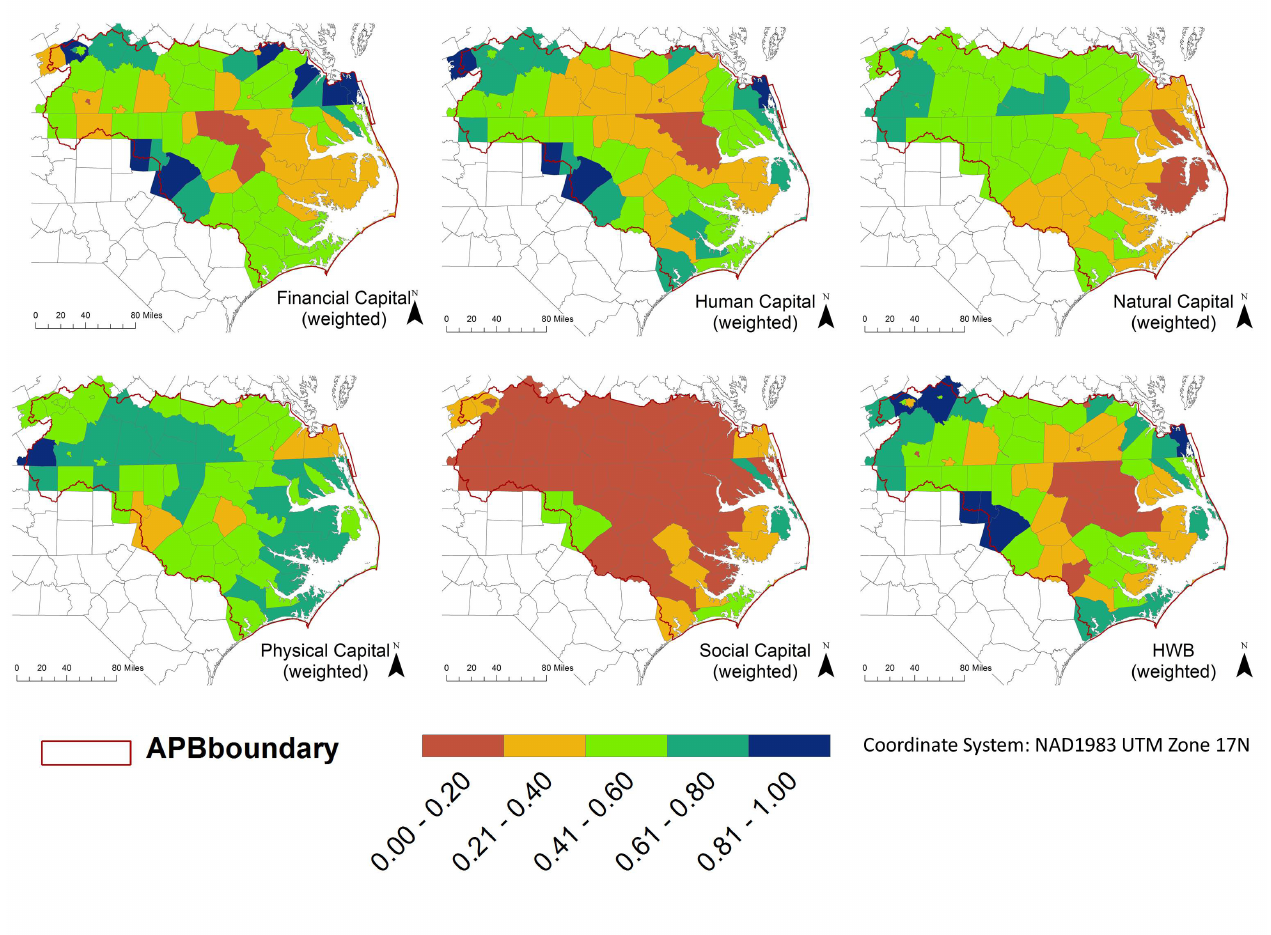
Fig. 3 . Capital asset conditions weighted by stakeholder participating ratings. Top (left to right): Financial, Human, Natural; Bottom (left to right): Physical, Social, and the weighted composite measure of HWB using Equation